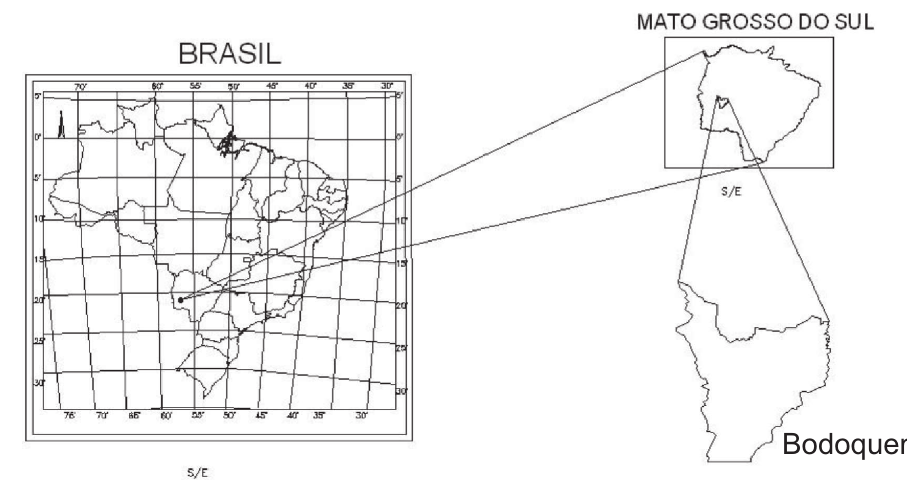
Figura 1. Localização do município de Bodoquena,